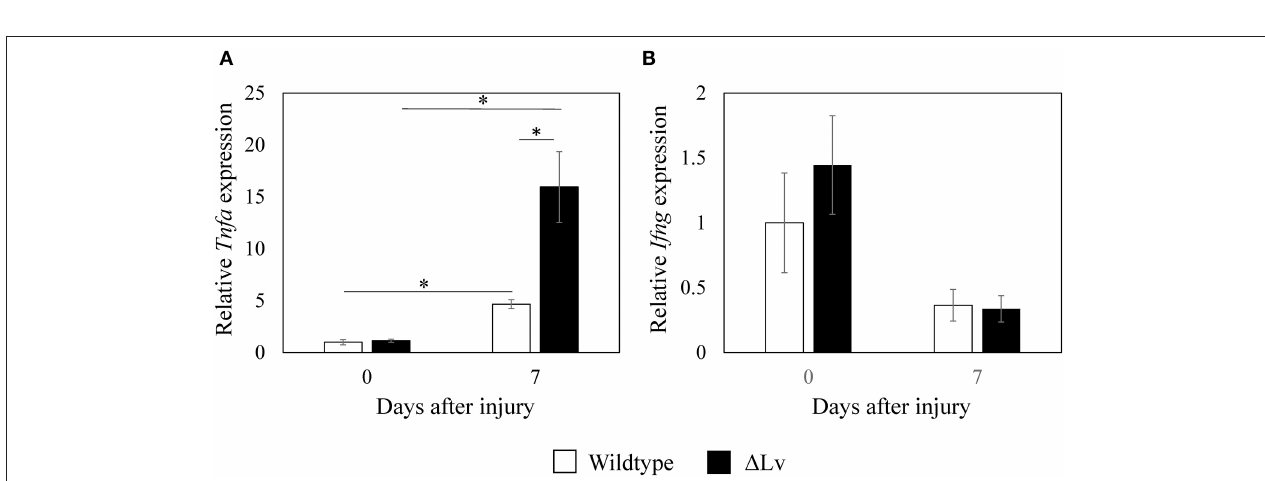
FIGURE 5 | Effect of peptide Lv deficiency on Tnfa and Ifng expression in synovium. (A) Tnfa and (B) Ifng expression in synovial tissue obtained from wild-type and peptide Lv- deficient ( 1 Lv) mice with synovitis. Values are mean ± SE ( n = 5). * p < 0.05.